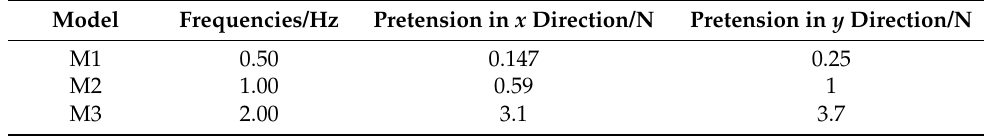
Table 4. Fundamental frequencies and pretension forces of different models.